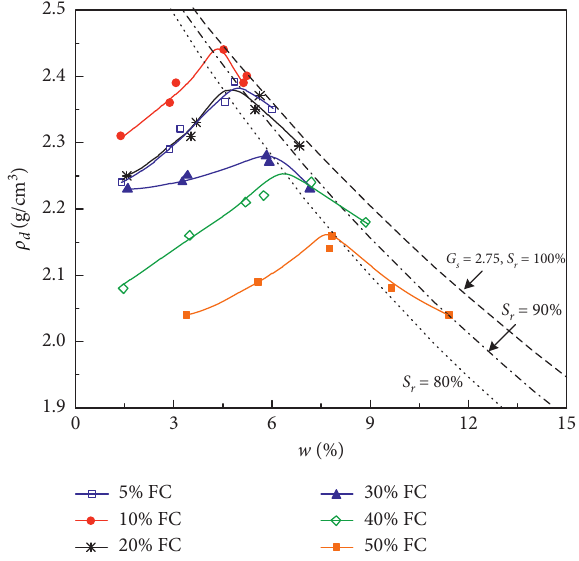
Figure 5: Compaction curves for gravel samples with different